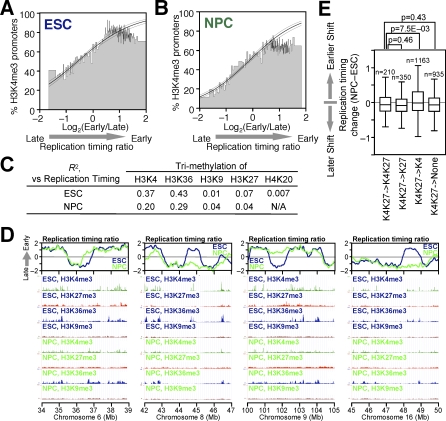
Relationship between Replication Timing and Histone Modifications(A and B) Correlation between replication timing and H3K4me3 of RefSeq gene promoters. The graphical format is the same as in Figure 5C and 5D, except that the heights of bins represent the percentages of H3K4me3-positive genes within each bin. Logistic regression (inner line) and 95% confidence intervals (outer lines) reveal a clear correlation in both ESCs (A) and NPCs (B) (p < 2 × 10−16 by the Likelihood Ratio test). H3K4me3 data were based on Mikkelsen et al [51].(C) Relationship between replication timing and histone modifications at the level of replication domains. Densities of different histone modifications (total intensity/domain size) based on a ChIP-Seq study [51] were calculated for all replication domains in a given state (ESC or NPC) and Pearson R
2 values between replication timing and different histone modification densities were obtained.(D) Comparison of replication timing and different histone modifications in four exemplary 5-Mb genomic regions in ESCs and NPCs.(E) Box plots showing the distribution of replication-timing changes of “bivalently” modified genes (i.e., K4K27) in ESCs that change to four different modification state (K4K27, K27, K4, or none) in NPCs. Genes that remained “bivalent” showed a distribution similar to the three other classes. The p-values were obtained from a two-tailed t-test for comparison of two unpaired groups.